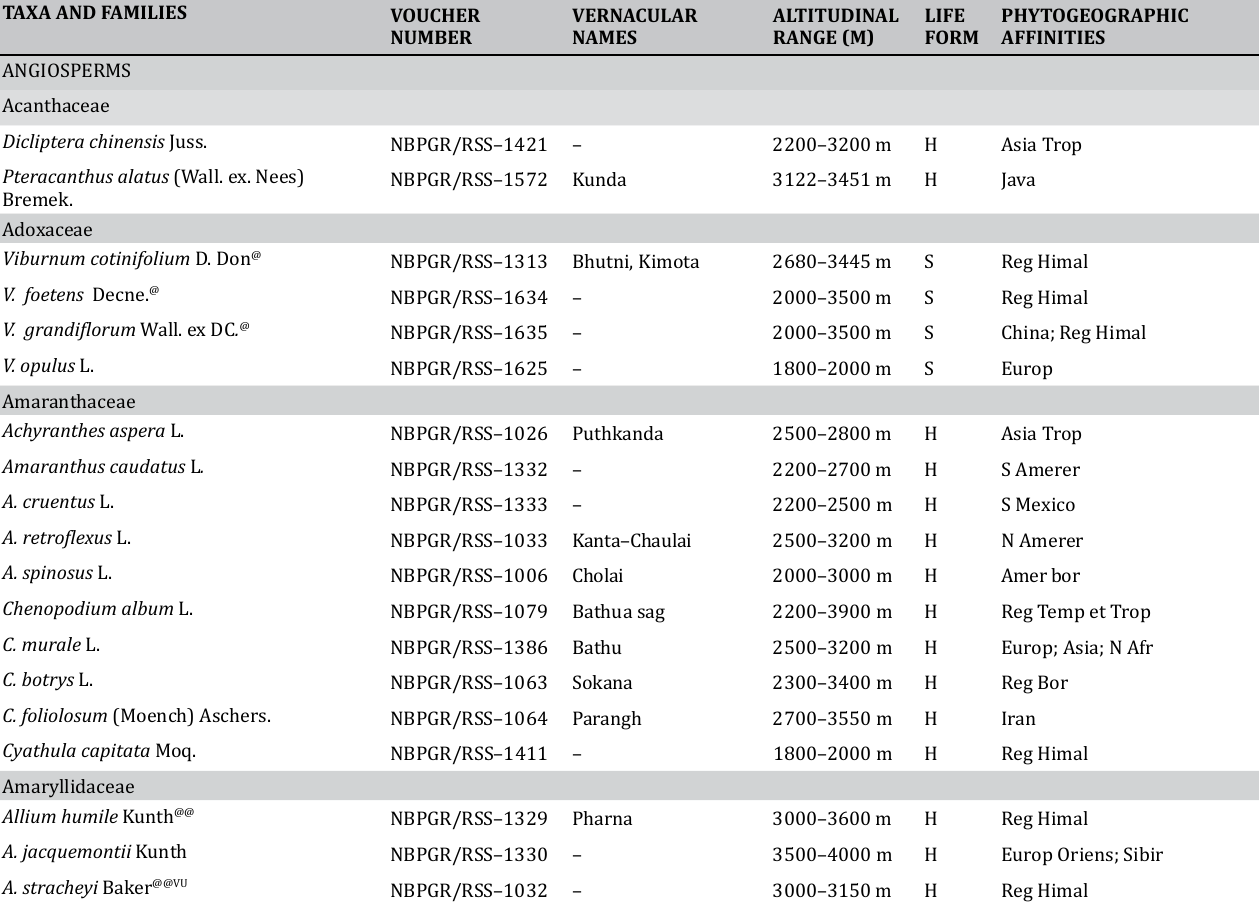
Table showing species inventory in Sangla valley. Abbreviations used: Afr=Africa; Alp=Alpine; Am=America; Amphig=Amphigaea; Amur=N Mongolia Russia and China; Arab=Arabia; Arct=Arctic; As=Asia; Austr=Australia; Baluchist=Baluchistan; Bor=Boreal (North Temperate Zone); Caucas=Caucasus; Centr=Central; Cosmop=Cosmopolitan; Europ=Europe; et=And; Geront=Gerontia (Greece); Himal=Himalayan; Hisp=Hispanic (Latin america); Ind=India; Mediterr=Mediterranean; Min=Minor; Mongol=Mongolia; N.Zel=New Zealand; Occ=Occidental (Western hemisphere); or=origin; Oriens=Oriental, Reg=Region; Sibir=Siberia; Soongar=Soongarica; SubTrop=SubTropical; Temp=Temperate; Trop=Tropical and Turkist=Turkistan; CR=Critically Endangered; EN=Endangered VU= Vulnerable; @@=Endemic; @=Near Endemic; F=Fern; H=Herb; S=Shrub,